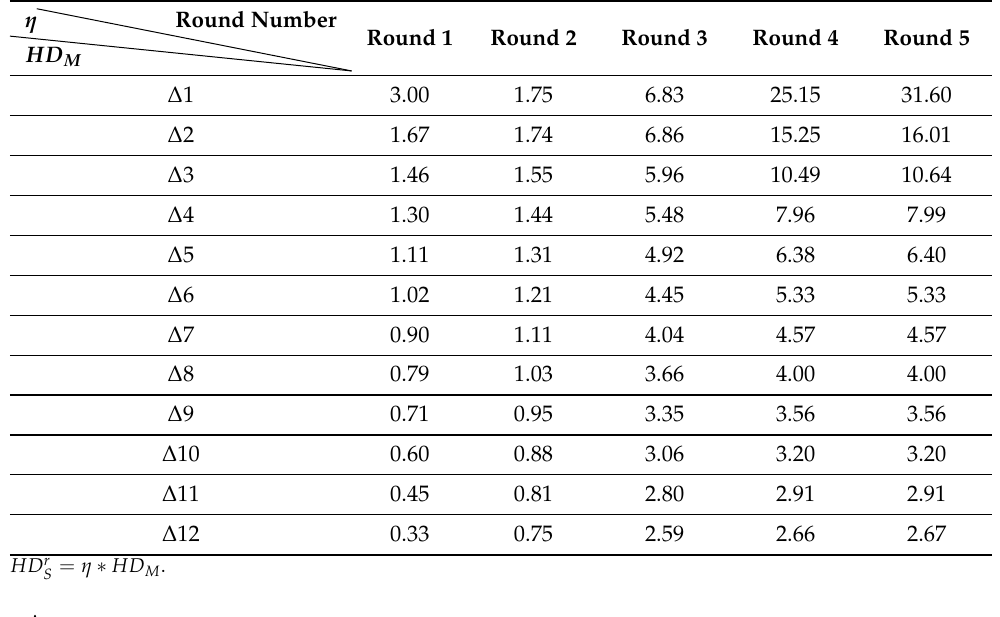
Table 4. Gain table of HD of MixColumn in the first round and HD of S-box in the following rounds.